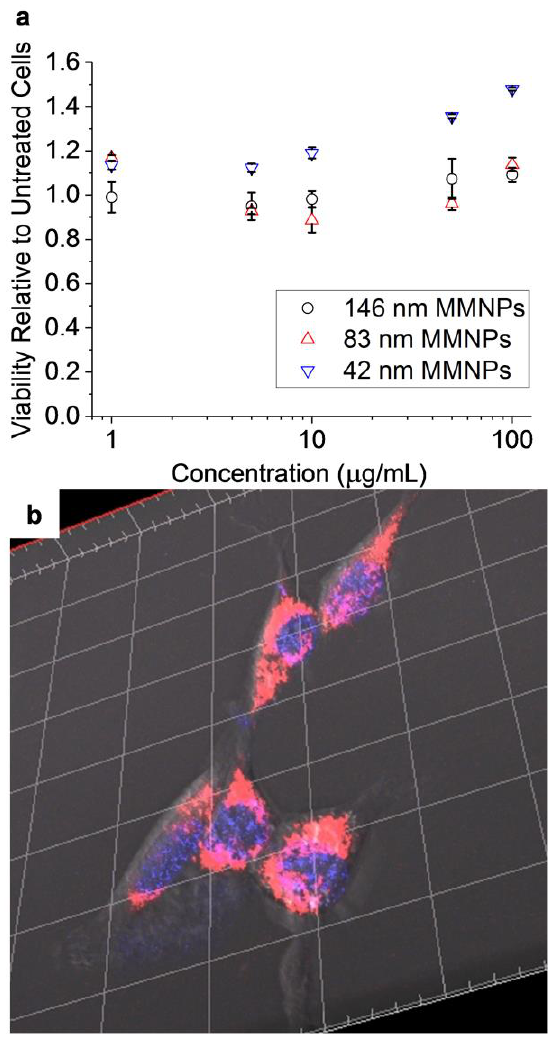
Figure 8. In vitro investigation of MMNP-cell interactions. ( a ) MMNP cytocompatibility with NIH/3T3 fibroblasts as measured by neutral red uptake viability assay. Error bars represent standard errors of triplicate experiments. ( b ) Representative confocal microscopy three-dimensional (3D) z -stack reconstruction image of Hoechst-stained NIH/3T3 fibroblasts treated with 20 µg mL −1 MMNP@PEG@RA123. Hoechst stain (blue) and rhodamine fluorescence (red/pink) are shown here; Scale bar: 20 µm between gridlines.